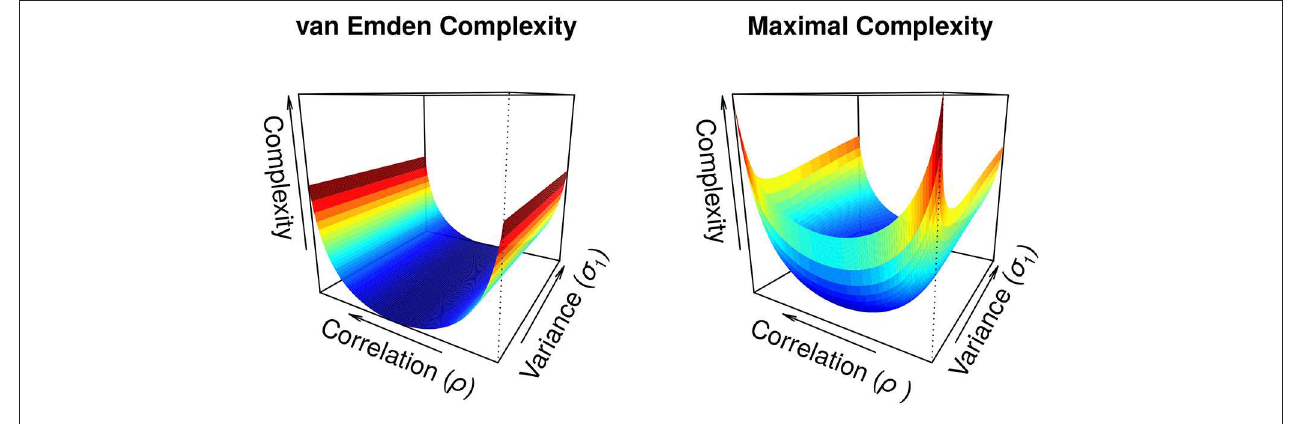
TABLE 1 | Invariance of complexity forms to different linear transformations of the covariates. Additive Multiplicative transforms transforms